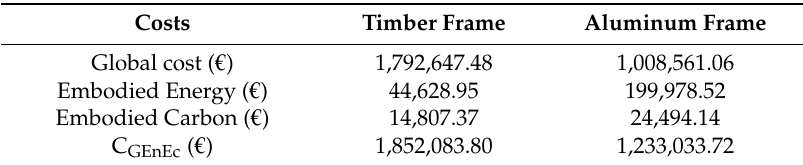
Table 10. Summary table of economic-environmental